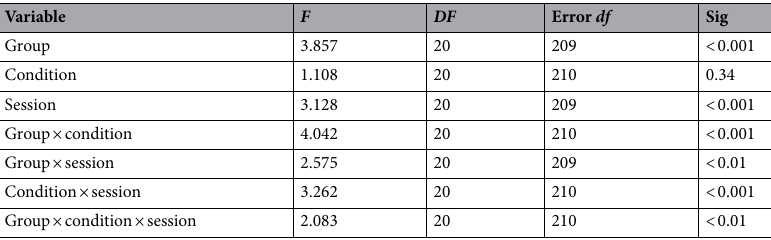
Table 1. MANOVA results. Dependent variable: 20 fNIRS channels for oxyhemoglobin level, Between subjects’ factor: Condition (Resting State vs Flat object vs Sharp-tip object), and Session (Time-to-contact detection vs Observation-only) as within-subject factors, and Group (FM patients vs Controls). The Roy square was